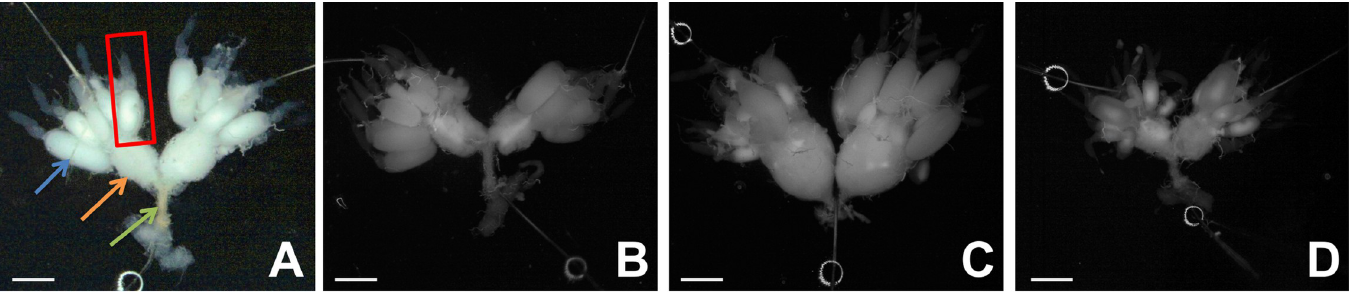
Fig 3. Representative micrographs obtained with a stereoscopic microscope of 4-day-old T . molitor ovaries isolated from control females injected with physiological saline (B), yamamarin (C) and C16-yamamarin (D) at concentrations of 10 − 7 M. (A) Representative picture of ovary: red frame—single ovariole, blue arrow—terminal oocyte, orange arrow—lateral oviduct, green arrow—common oviduct. The white scale bar corresponds to 1000 μ m.